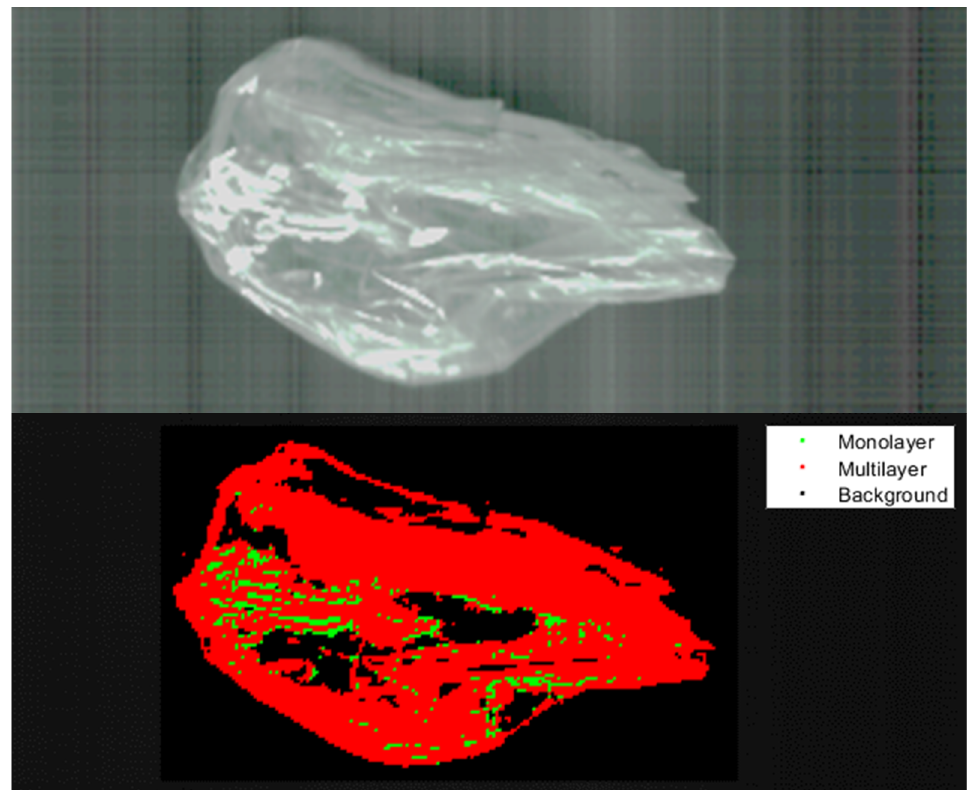
Figure 26. Classification of a cheese packaging film not used in training and testing with the SNN.